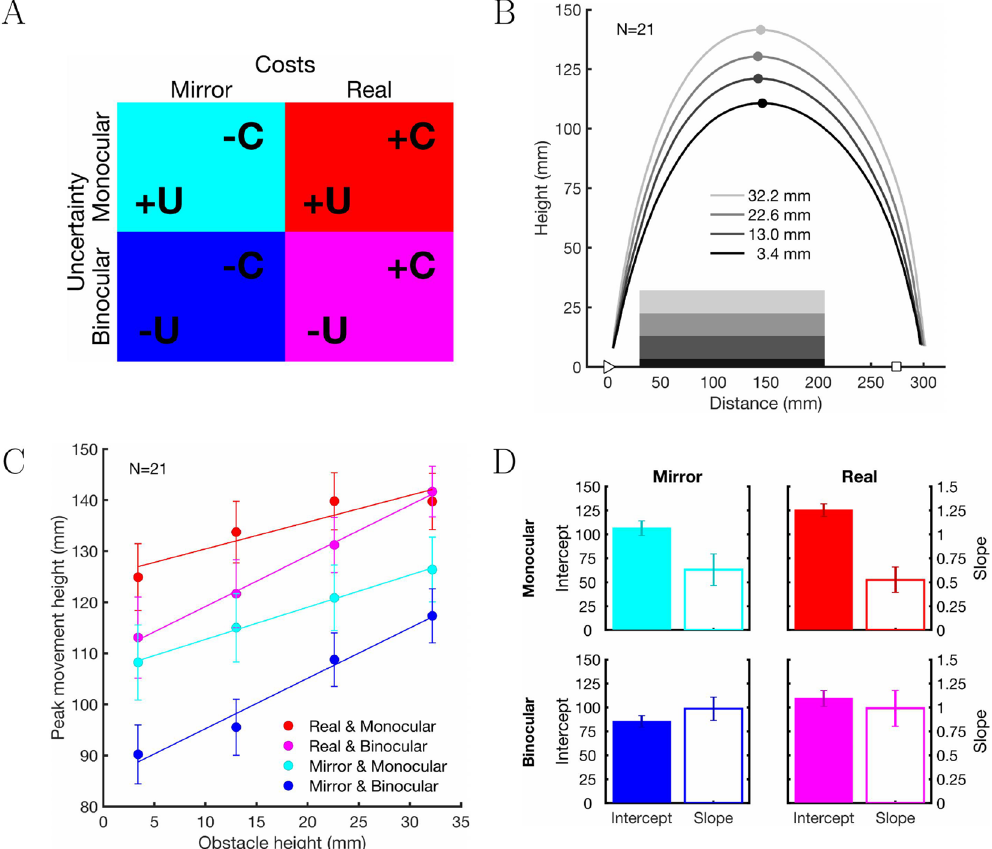
Figure 1. ( A ) Four experimental conditions: perceptual uncertainty is shown in rows and costs of mistakes are shown in columns. U represents the magnitude of perceptual (visual) uncertainty (+U: higher uncertainty, –U: lower uncertainty), and C represents the magnitude of costs of mistakes during movement execution (+C: higher cost, –C: lower costs). ( B ) Example hand movement trajectories for the real & binocular condition normalized and averaged over participants separately for the four different obstacle heights (3.4, 13.0, 22.6, and 32.2 mm). The x-axis shows the distance from the start position (triangle) to the target position (square) in millimetres. The y-axis shows the height of the movements (mm). The grey-shaded horizontal bars indicate the height and extent of the different obstacles. Curves show the averaged trajectories for the different obstacle heights as indicated by the grey level. The filled circles indicate the peak height of the trajectories (mm). ( C ) Peak height (mm) averaged over 21 participants separately for the four experimental conditions. (red: real & monocular , magenta: real & binocular , cyan: mirror & monocular , blue: mirror & binocular ). The x-axis shows the height of the obstacles (mm) and the y-axis shows the peak height of the reaching movements (mm). Error bars show ±1 SEM. Straight lines show linear regression lines. ( D ) Mean intercepts (baseline safety margin) and slopes (sensitivity to changes in obstacle height) for each of the four combinations of experimental conditions (as shown in A ). Baseline safety margins were largest for the monocular & real condition (red), and lowest for the binocular & mirror condition (blue). Error bars show ±1